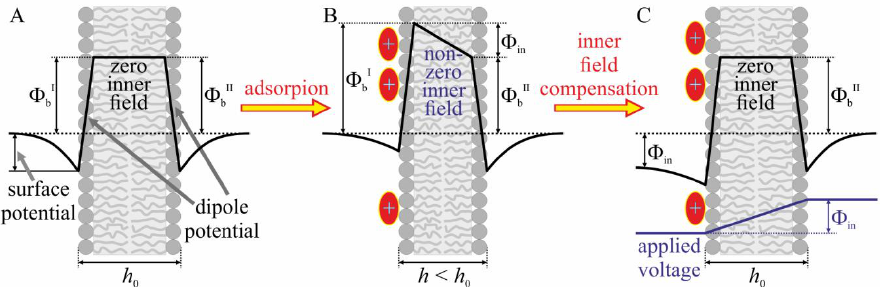
Figure 2. Illustration of the method of inner membrane field compensation; A — initial distribution of the electric potential in the vicinity of the membrane. The boundary potential Φ b is a sum of the dipole potential and surface potential measured in the di ff use part of electrical double layer. Due to the symmetry, the electric potential is constant inside the membrane, i.e., the inner electric field is equal to zero. The membrane thickness is denoted as h 0 . B —Asymmetric (one-side) adsorption of charged molecules to the membrane yields asymmetric distribution of the electric potential: Φ in now drops inside the membrane. Non-zero inner electric field arises, leading to a decrease in membrane thickness, h < h 0 , and an increase in membrane electric capacitance, due to the electrostriction. C —Application of the external voltage equal to Φ in compensates for the inner membrane field. The equality of the applied voltage to Φ in can be controlled by measuring the dependence of membrane electric capacitance on the applied voltage. When the capacitance is minimal (the membrane thickness is maximal and equal to h 0 ), the inner electric field is equal to zero (as in panel A) and, thus, the applied voltage is equal to Φ in